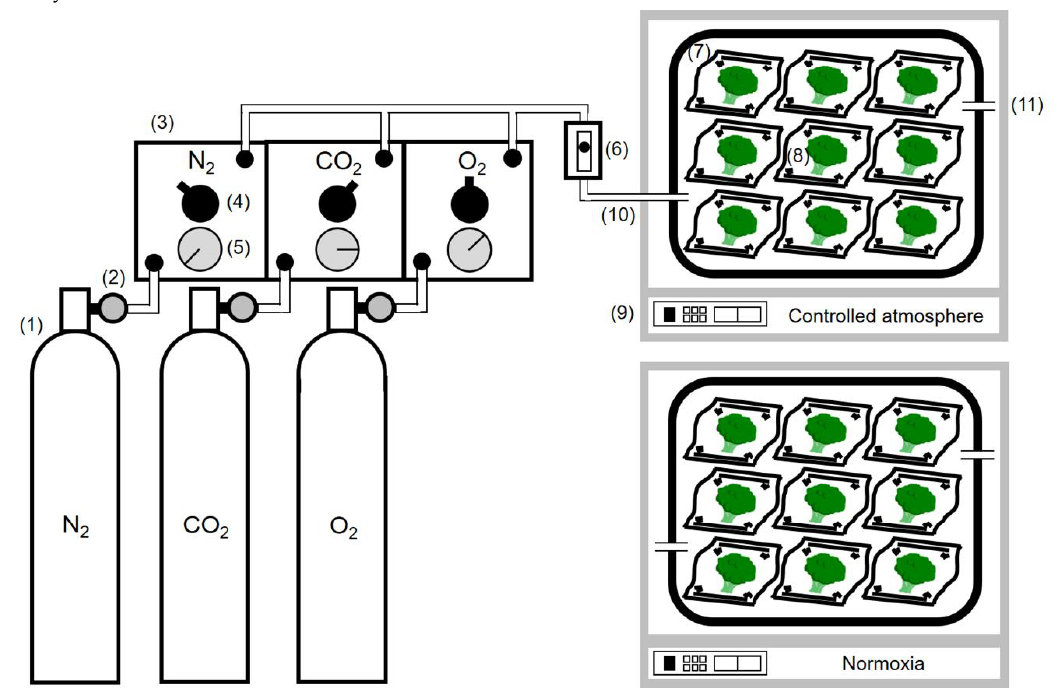
Figure 1. Schematic diagram of storage system for broccoli heads under controlled atmosphere and normoxia. ( 1 ) Gas cylinders, ( 2 ) regulators, ( 3 ) LogMIX gas mixture device (Fronto Co., Ltd., Kunitachi, Japan), ( 4 ) gas flow controller, ( 5 ) pressure gauge, ( 6 ) flowmeter, ( 7 ) 7-L acrylic jar (V-7, Shin-ei Sangyou Co., Ltd., Daito, Japan), ( 8 ) samples (broccoli heads), ( 9 ) temperature control units, ( 10 ) inlet, ( 11 ) outlet.